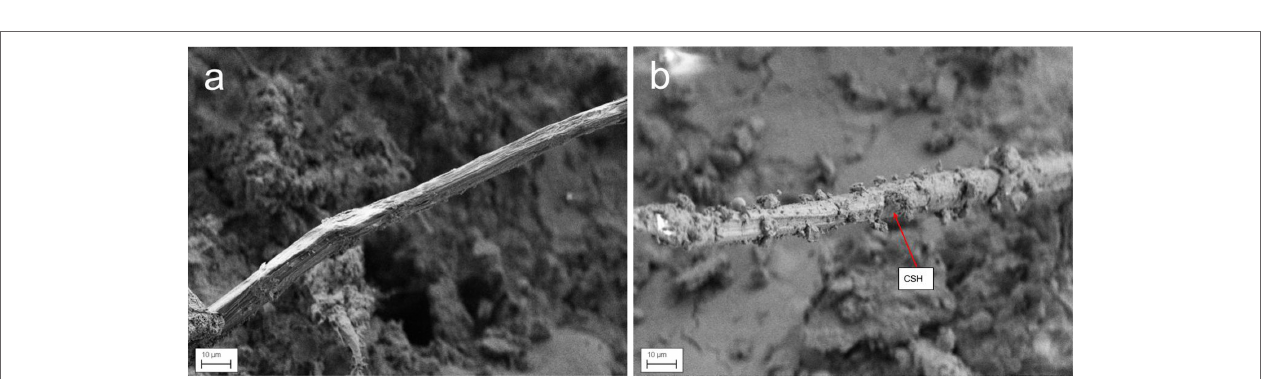
FIGURE 8 | Exposed fiber surface after composite failure at (cid:2) 2,000 magnification: (A) untreated fiber and (B) treated fiber.